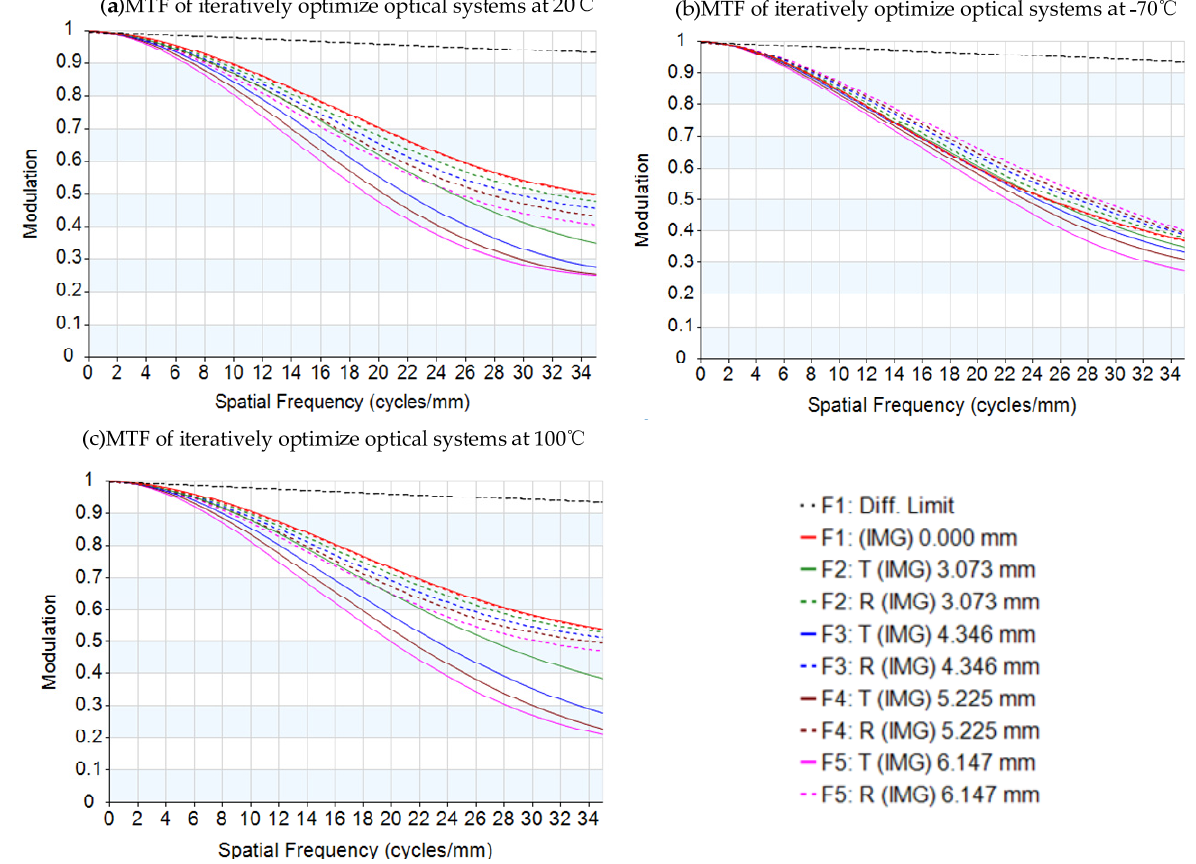
◦ C, ( b ) − 70 ◦ C, and ( c ) 100 ◦